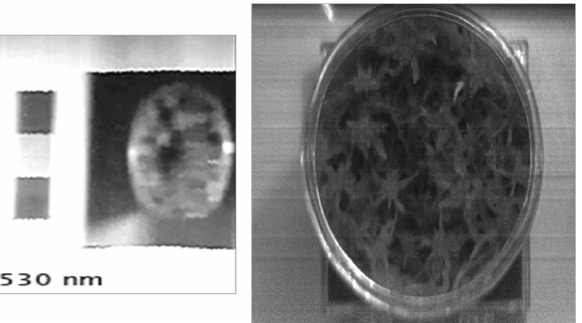
Figure 7. Spatial dataset comparison between the Hyperspectral Smartphone ( left ) and the Low- Cost High-Resolution instrument ( right